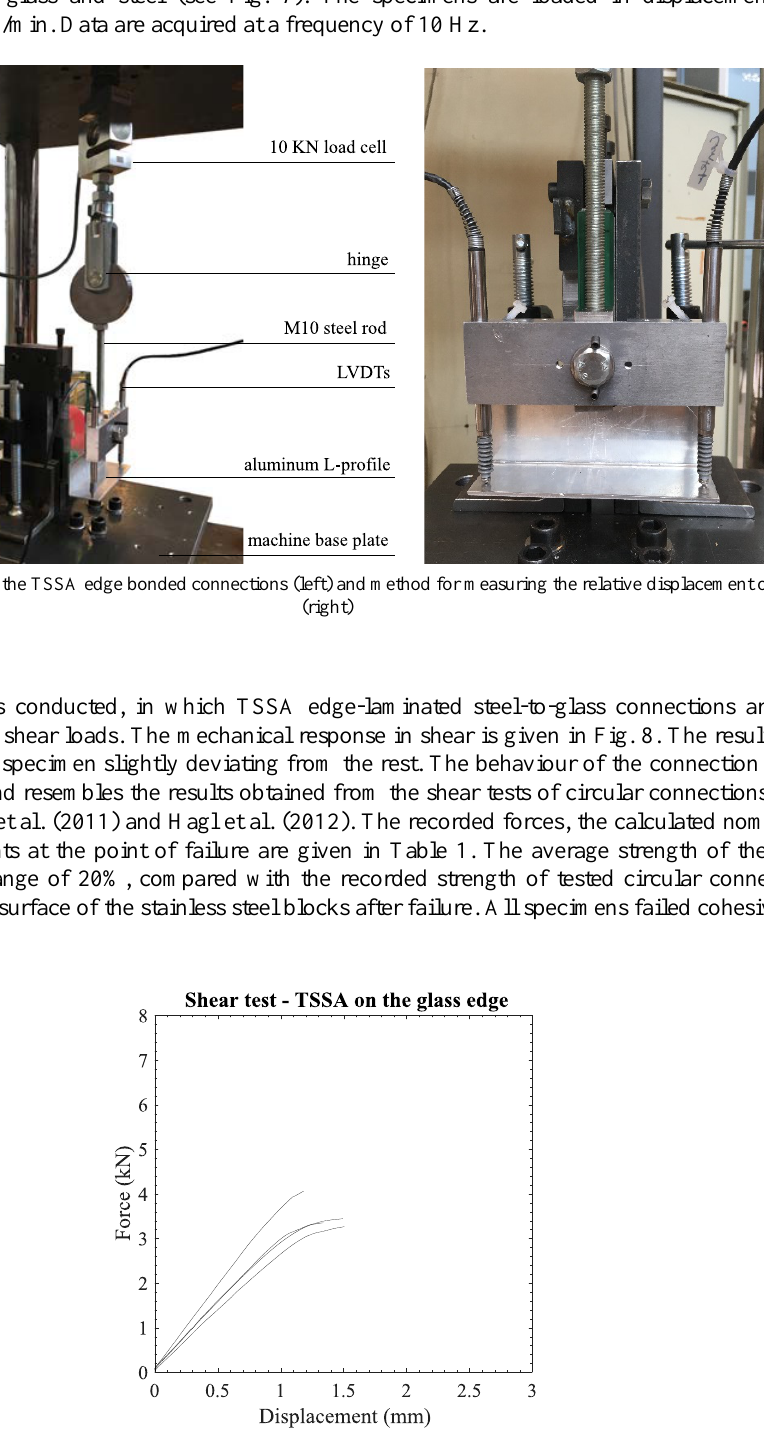
Fig. 8 Experimental results of TSSA laminated connections on the glass edge under shear